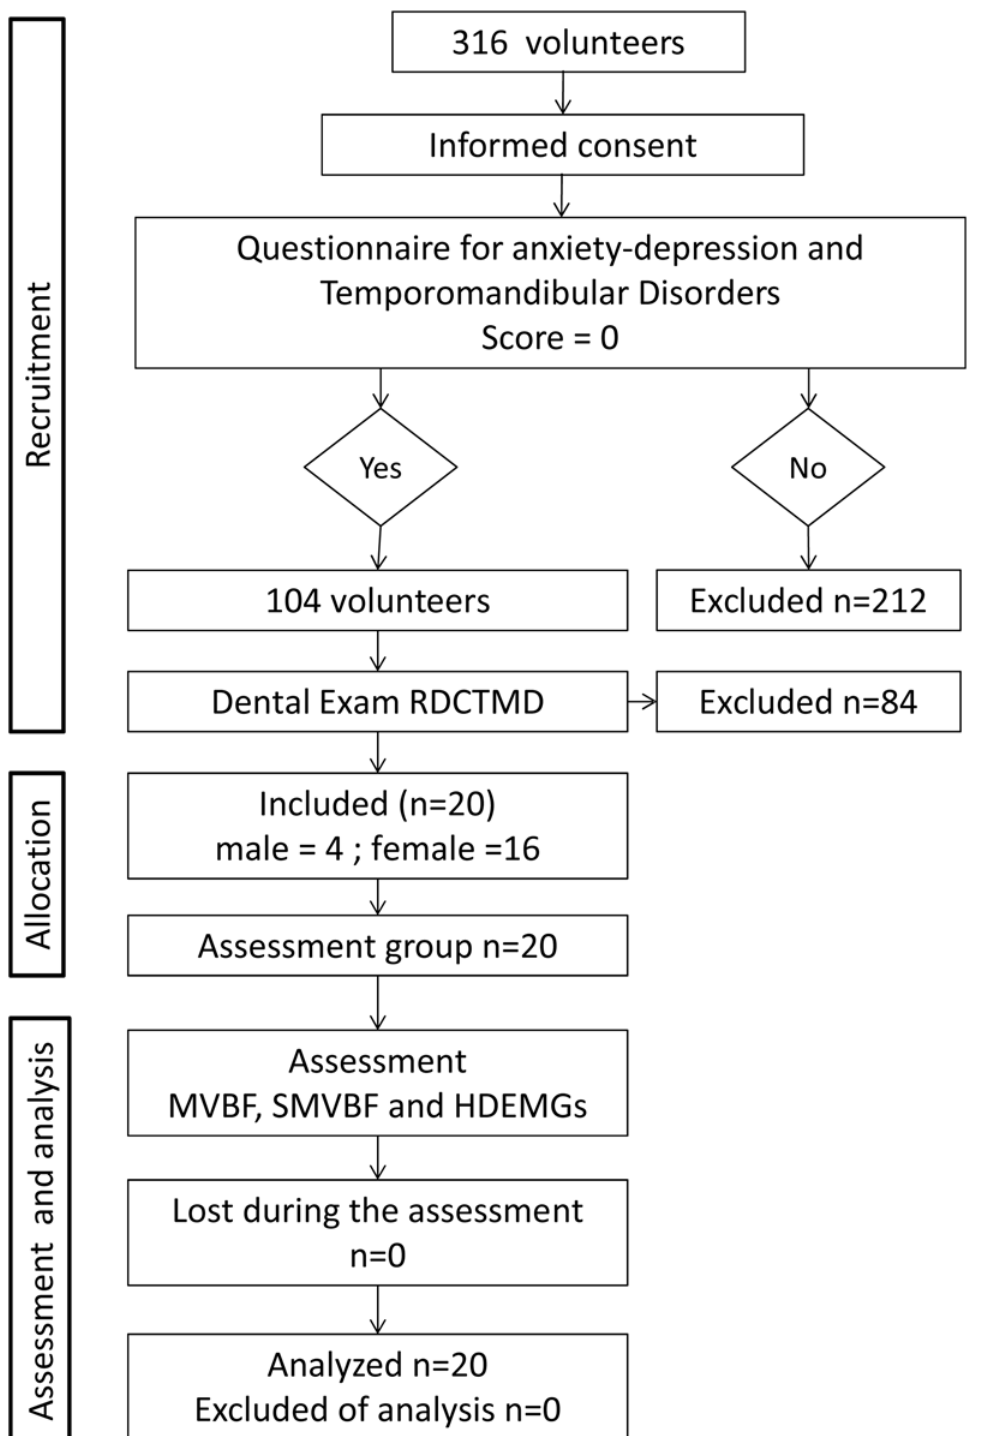
Figure 1. Study design. RDCTMD: Research diagnostic criteria for temporomandibular disorders. MVBF: Maximal voluntary bite force. SMVBF: Submaximal voluntary bite force. HDEMGs: High density surface electromyography.